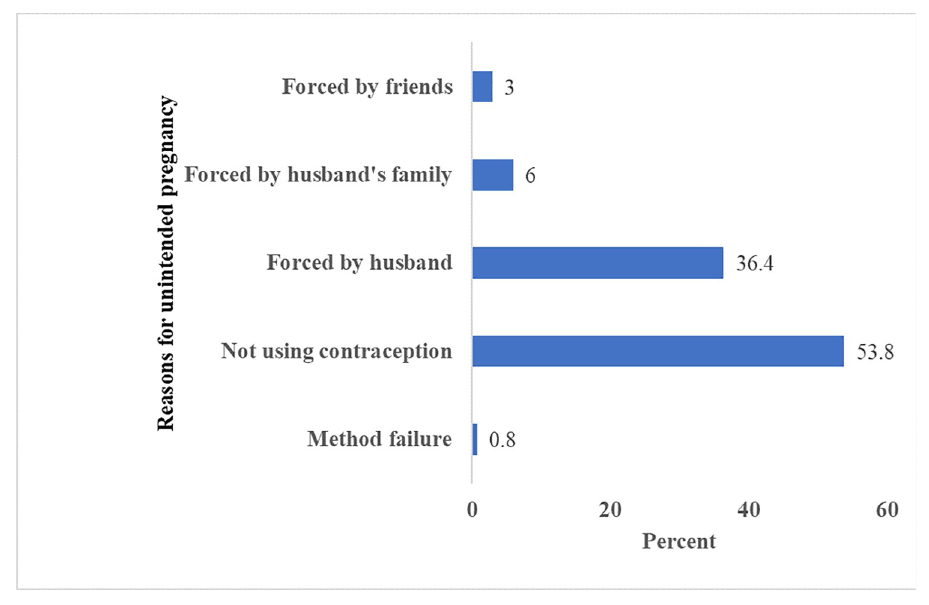
Fig 4. Concerning age at first marriage, pregnant mothers who had a marriage before 18 years old were 3 times (AOR = 3.195, 95% CI 1.757, 5.811) at risk of unintended pregnancy than preg- nant women who married at age 18 and above. The occupational status of respondents is nega- tively associated with unintended pregnancy. Women that become government employee were 96% times less likely to face unintended pregnancy (AOR = 0.039, 95% CI: 0.002, 0.988). Those women who decided on their health care by themselves were 88% times less likely to have an unintended pregnancy as compared to those decisions made by others (her family) (AOR = 0.122, 95%CI: 0.035, 0.431). Discussion with husband about modern contraceptive methods is also negatively associated with unintended pregnancy. Those women who discuss about contraceptives with their hus- band were 97% times less likely to have an unintended pregnancy as compared to those didn’t discuss (AOR = 0.027, 95%CI: 0.035, 0.431). Ever heard modern contraceptive methods are negatively associated with unintended pregnancy. Those women who ever heard about contra- ceptives were 74% times less likely to have an unintended pregnancy than those who never heard (AOR = 0.260; 95% CI: 0.077, 0.876). Women that used any type of contraceptive method before were 65% times less likely to face an unplanned pregnancy, when compared with women that no used contraceptives before (AOR = 0.348, 95% CI: 0.168, 0.717). Not using contraception due to fear of side effects is positively associated with unintended preg- nancy. Women who were not using modern contraceptive methods due to fear of side effects were almost 8 times more likely to have an unintended pregnancy as compared to women who did not fear of side effects (AOR = 7.868, 95%CI: 1.767, 35.028). Age of women at first preg- nancy is also positively associated with unintended pregnancy. Women who had their first pregnancy below 18 years were 23 times more likely to experience unintended pregnancy when compared to women who had their first pregnancy at 18 years and above (AOR = 23.660, 95%CI: 12.573, 44.522). The interval between births is also strongly associated with unintended pregnancy. Those women who have an average birth interval of below 2 years were almost 3 times more likely to have unintended pregnancy when compared to women who have an average birth interval of 2 years and above (AOR = 3.472, 95%CI:1.392,8.661).